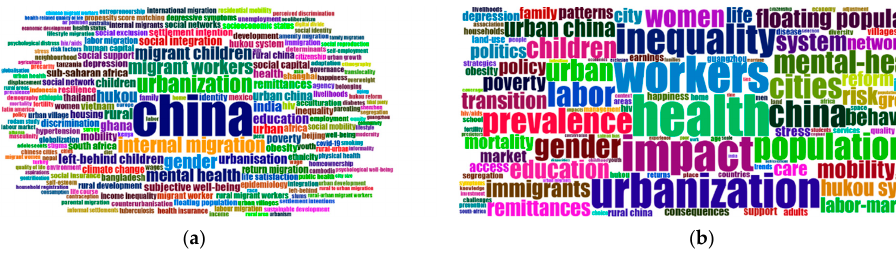
Figure 6. Word cloud of ranking distribution with author keywords ( a ) and Keywords Plus ( b ).